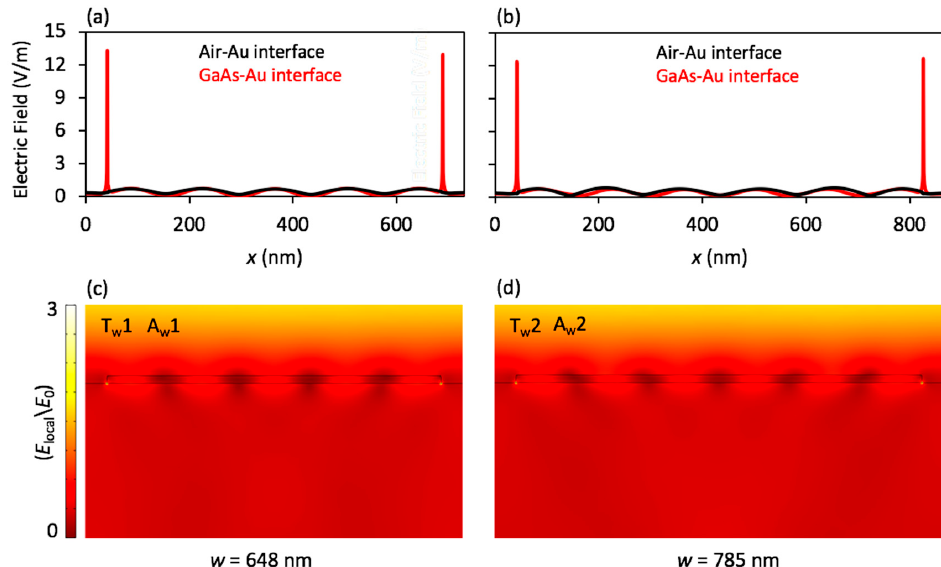
Figure 5. ( a , b ) Electric field distributions on the top and the bottom interfaces of the nanostructure and ( c , d ) for the entire model space at Rayleigh’s anomalies as shown in Figure 3, for sweeping w . In ( a ) and ( c ), T w 1 or A w 1 is located at P = 731 nm, ( w = 648 nm and g = 83 nm), and in ( b ) and ( d ), T w 2 or A w 2 is located at P = 868 nm, ( w = 785 nm and g = 83 nm). The electric field distributions at A sp 1 and A wood 1 peaks for the top and bottom interfaces, and for the entire model space are shown in Figure